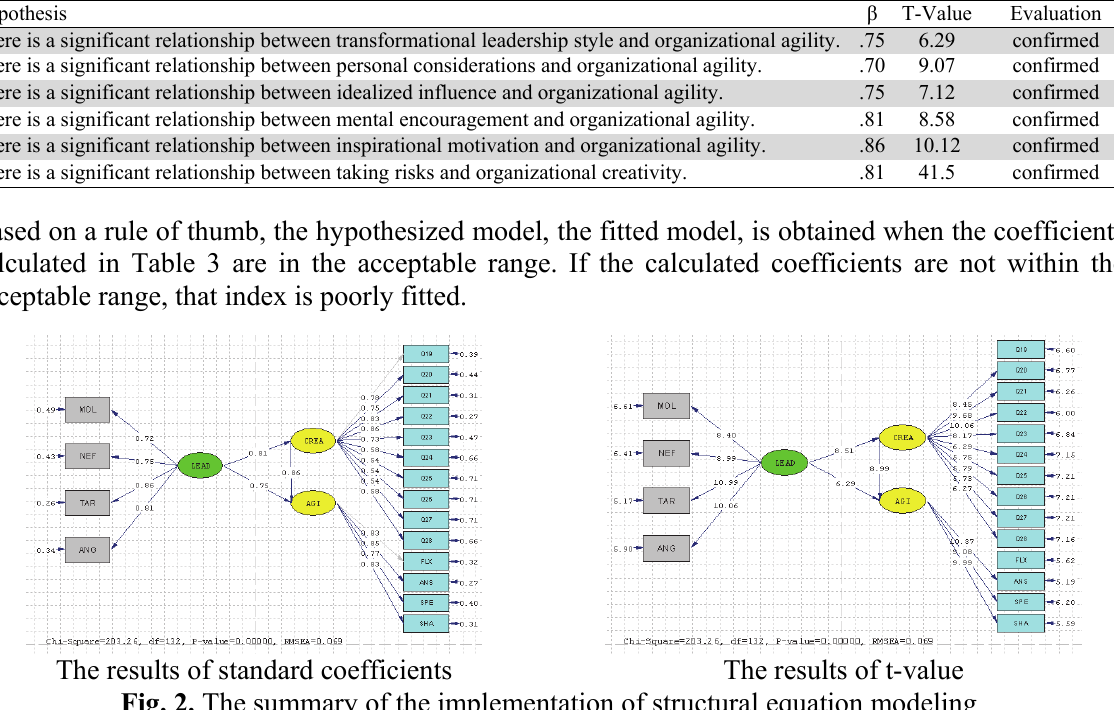
Summary of the research sub-hypotheses and test results